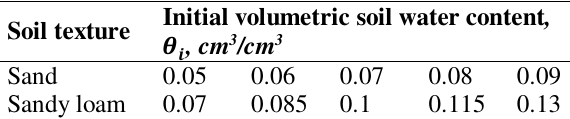
Values of initial soil water content used for the simulations in USDA classification system.